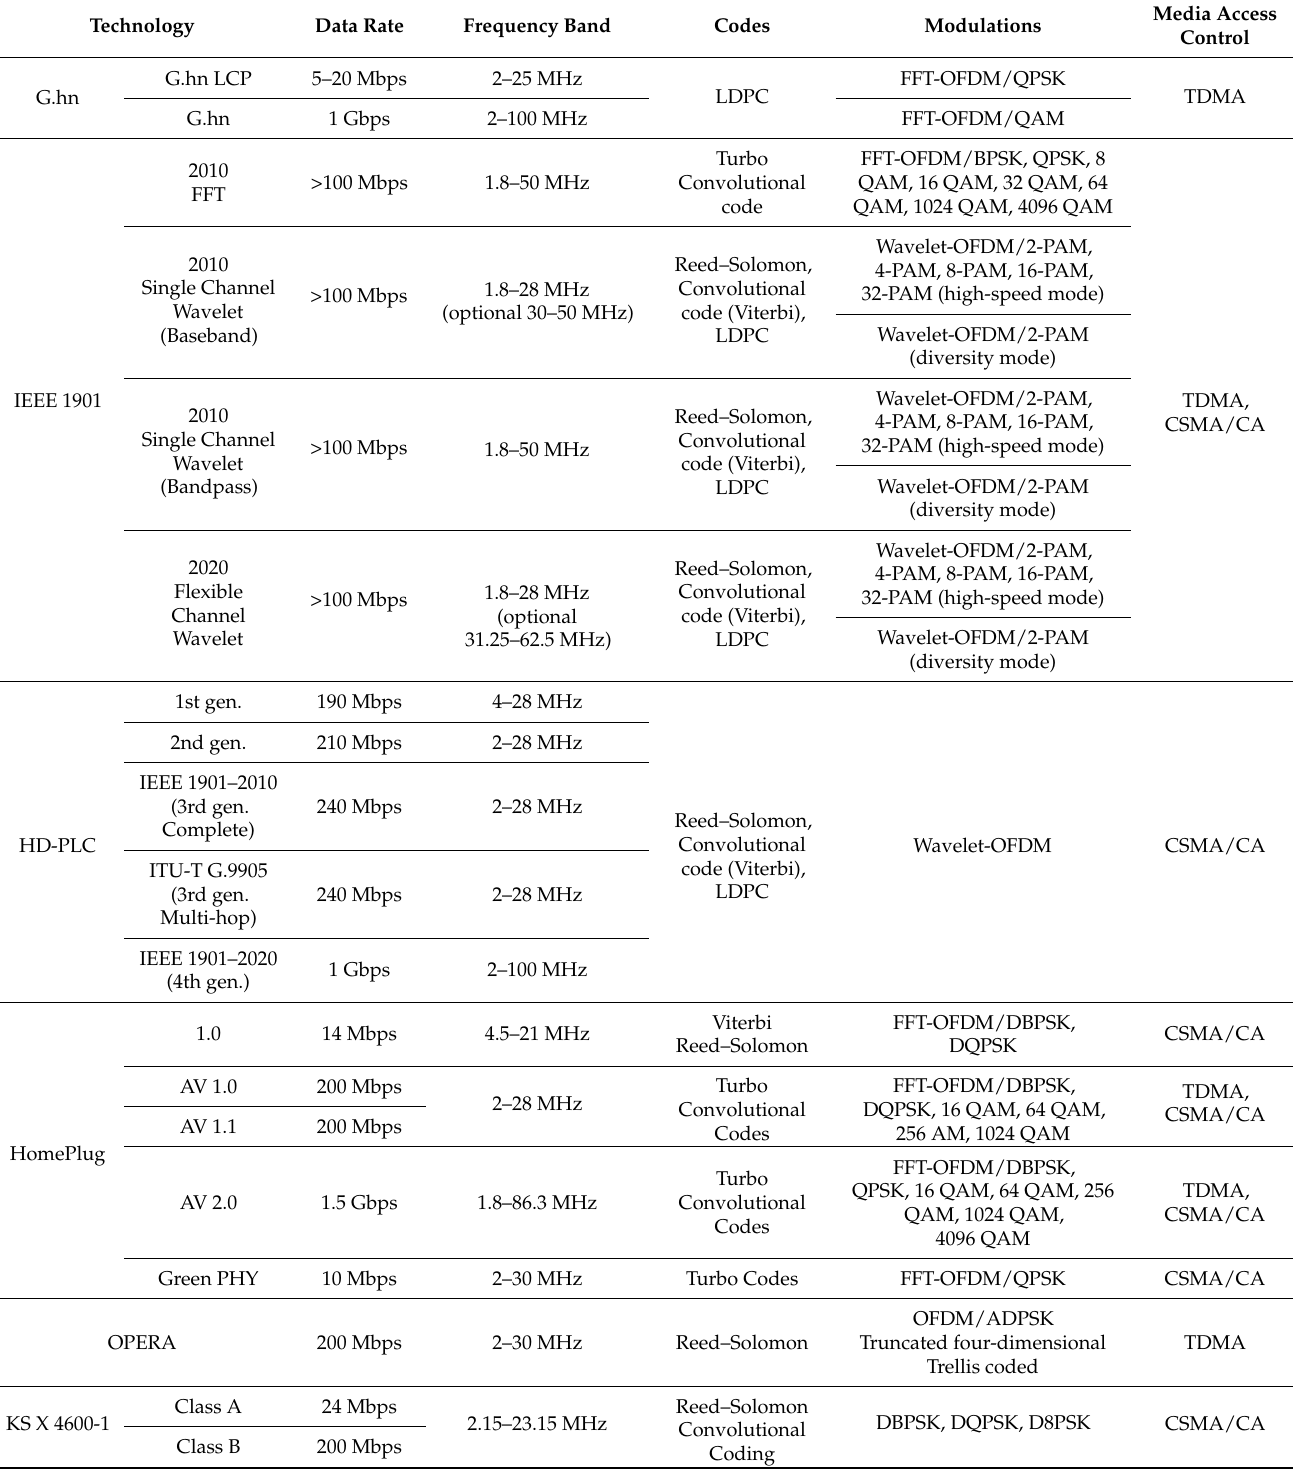
Table 1. Comparison of technical specifications of main BPL